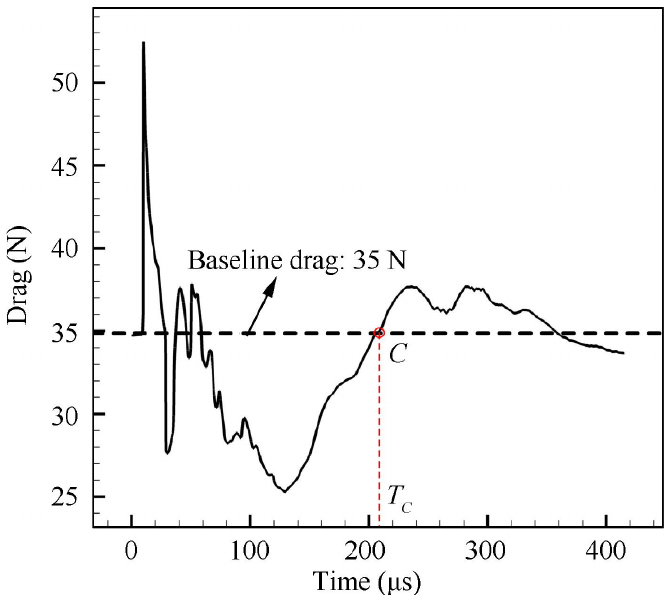
Figure 32. Change in drag in response to the opposing SparkJet. Adapted from [67].